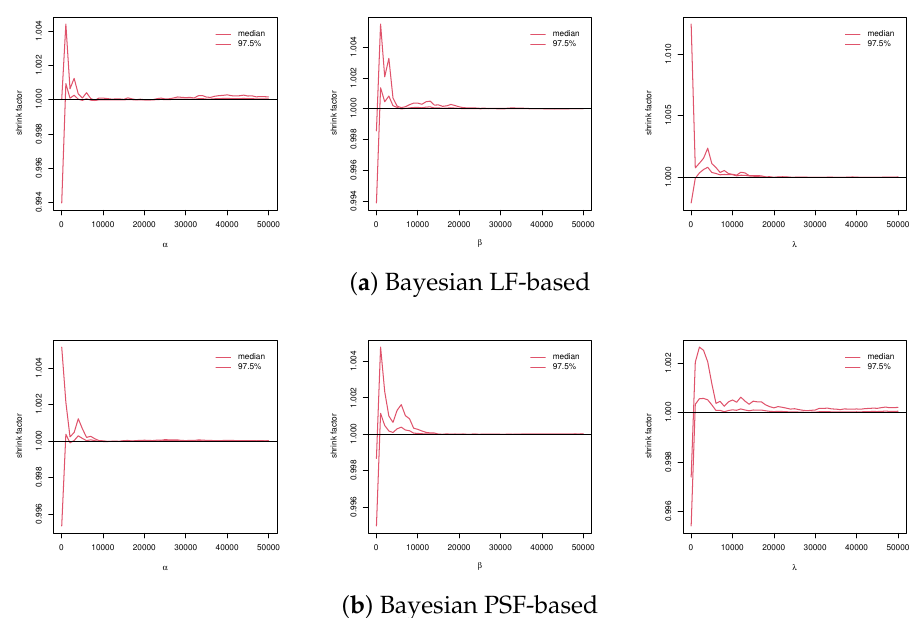
Figure 10. Density ( left ) and trace ( right ) plots of α , β , and λ from micro-droplet data.